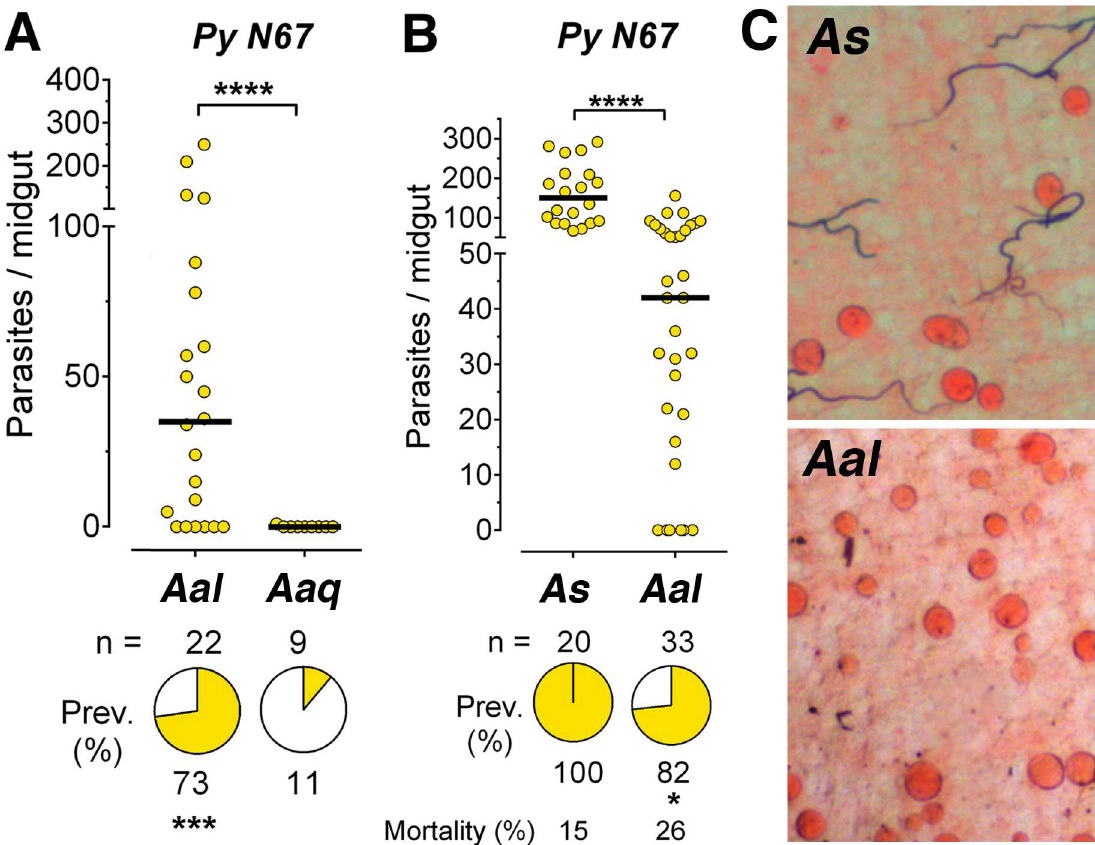
Fig 5. Infection of A . albimanus with P . yoelii nigeriensis N67 . (A and B) Susceptibility of Anophelesalbimanus (Aal), Anophelesaquasalis (Aaq) and Anophelesstephensi (As) mosquitoesto infectionwith P . yoeliinigeriensisN67 (PyN67), without antibiotics or uric acid. (C) PyN67 oocysts in As and Aal mosquitoes 8 days post infection. Each dot represents the number of oocysts present on an individual midgut 10–12 days post-infection and the median numberof oocysts is indicatedby the black line. The medianswere comparedusing the Mann-Whitney test and the infection prevalence using Chi-square ( * p < 0.05, *** p < 0.001, **** p < 0.0001).